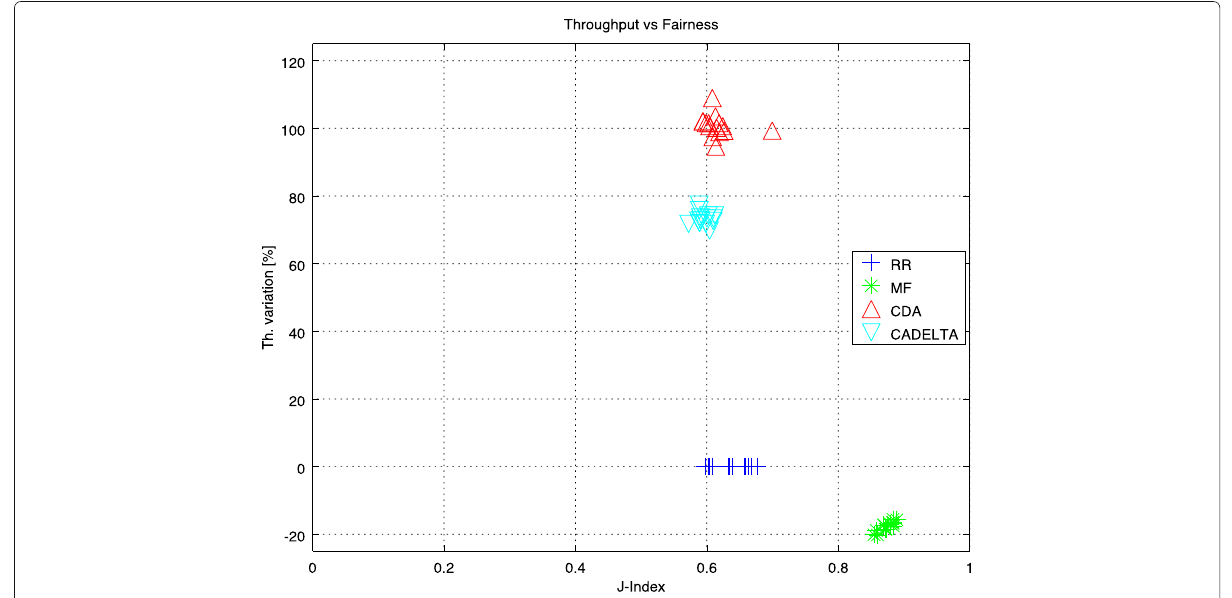
Fig. 13 Throughput vs fairness—traffic monitoring (25%), video surveillance (LQ) (25%) and video surveillance (HQ) (50%)